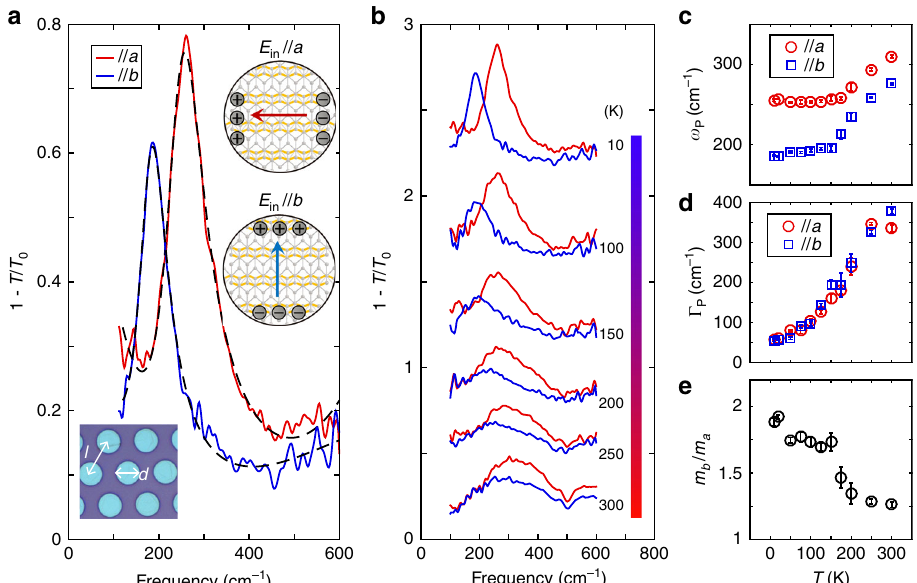
Fig. 2 Anisotropic plasmons in WTe 2 microdisk array with strong temperature dependence. a Extinction spectra of the microdisk array fabricated on the fi lm in Fig. 1c along a and b axes at 10 K, with Si/SiO fi ttings (see Methods for the fi tting 2 as substrates. The black dashed curves are the corresponding procedure). The upturn of the spectra along the a axis at low energy is due to the Drude absorption from the unpatterned fi lm outside the patterned area. Left inset: optical microscope image of the microdisk array, with l = 8 μ m and d = 5 μ m. Right inset: schematics of the plasmon resonance modes in the disk cavities with different polarizations. b Temperature dependence of the extinction spectra of the microdisk array with polarization along a and b axes. The spectra are vertically displaced for clarity. c , d , e Temperature dependence of the fi tted plasmonic frequencies, resonance widths, and the calculated effective mass ratio based on the plasmon spectra. All error bars are de fi ned from fi